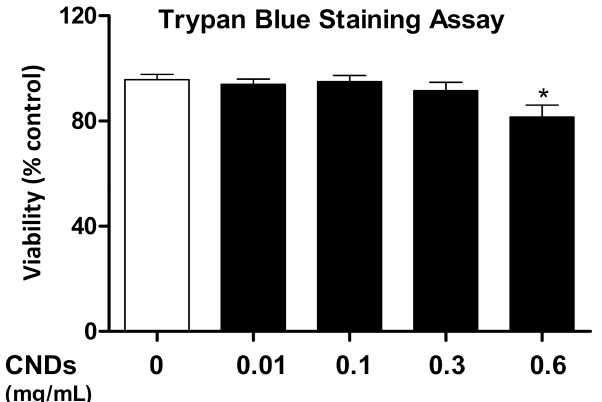
Figure 3. Effect of CNDs on cell viability (Trypan Blue). THP-1 cells were treated with 3 ng/mL TPA in the presence or absence of 0.01, 0.1, 0.3, or 0.6 mg/mL CNDs in RPMI media for 72 h, upon which media was refreshed. Then, cells were left to incubate for another 72 h. Cells were harvested, and a cell count performed using a hemocytometer and Trypan Blue. All data represent mean ± SEM ( n = 3, *, p < 0.05 vs. control).